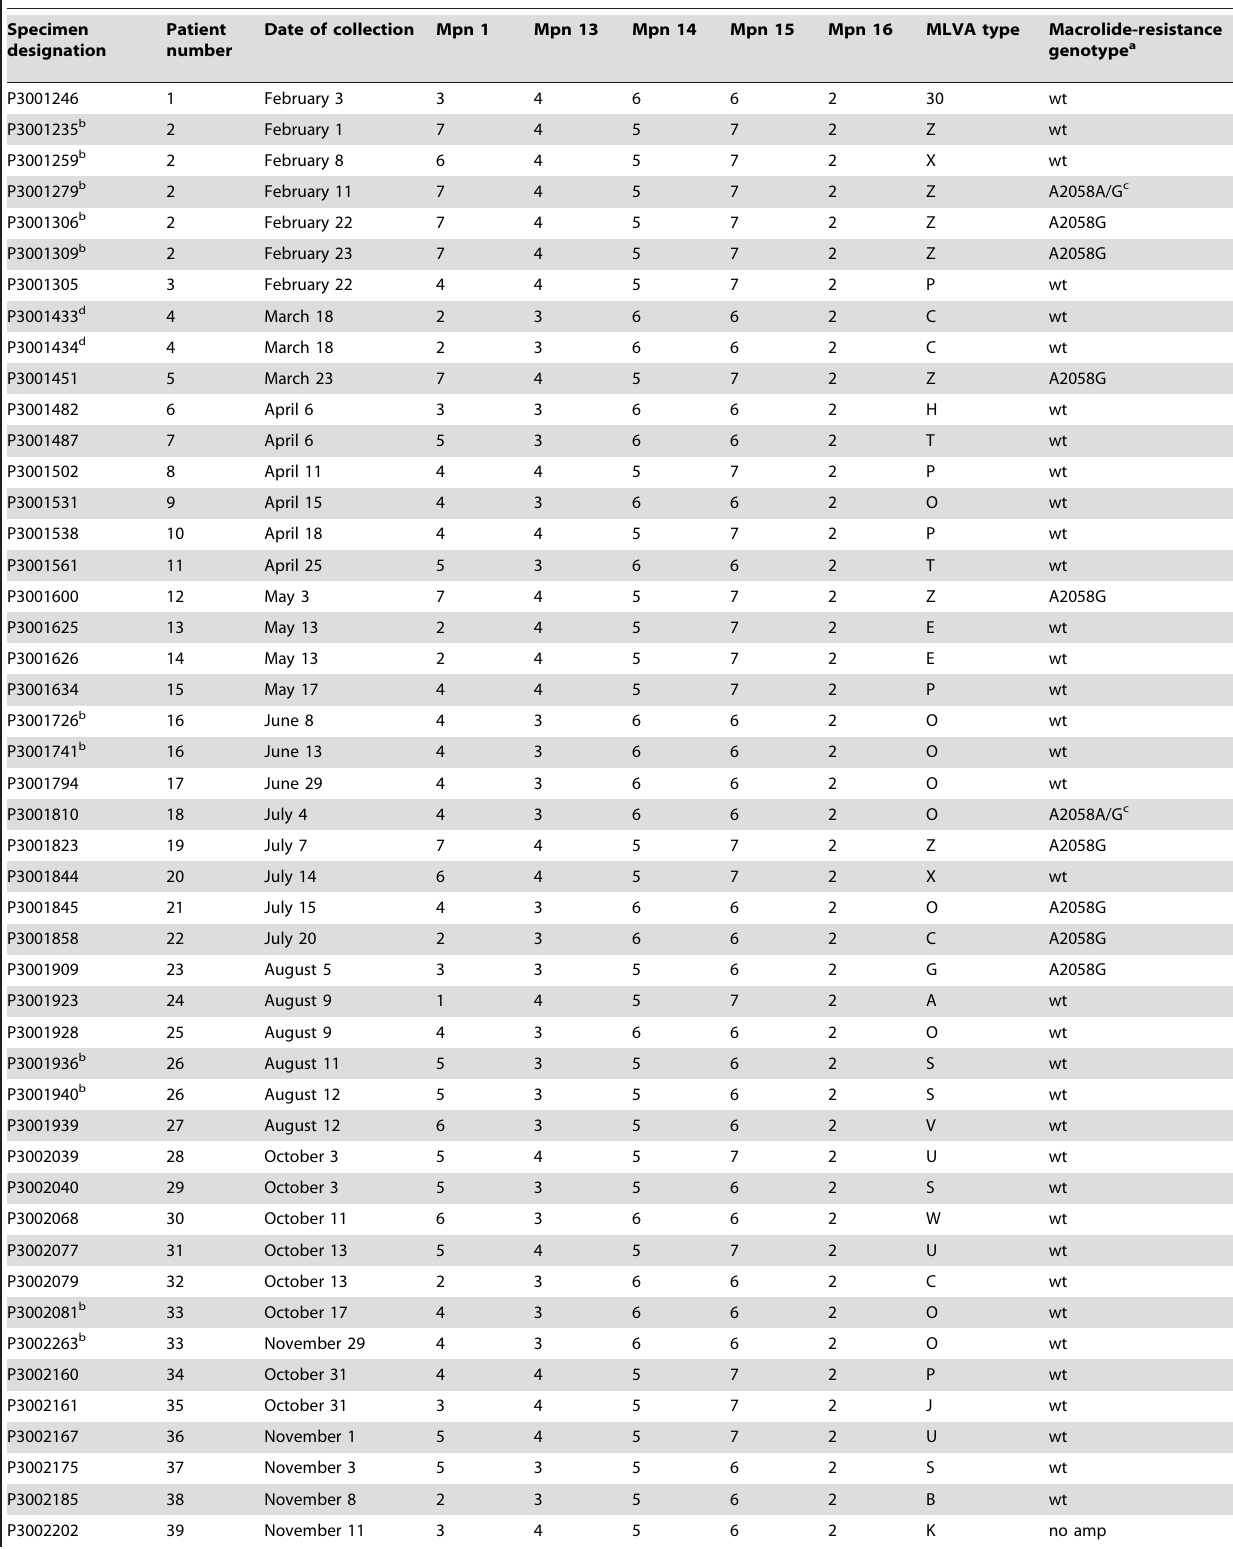
Table 3. Characteristics of 49 M. pneumoniae- positive throat swab specimens collected at the Hadassah-Hebrew University Medical Center, Jerusalem, Israel in 2010, from 41